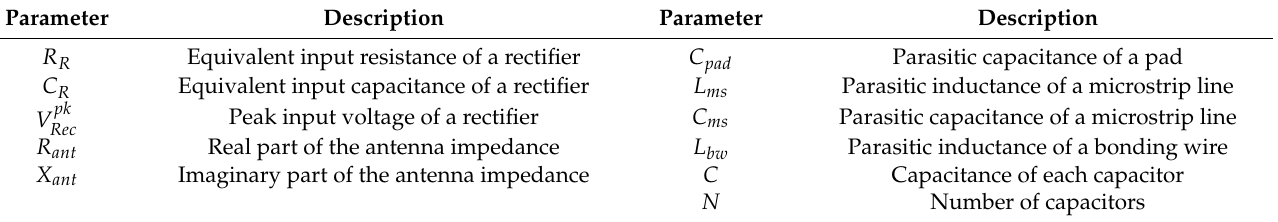
Table 1. Description of parameters.